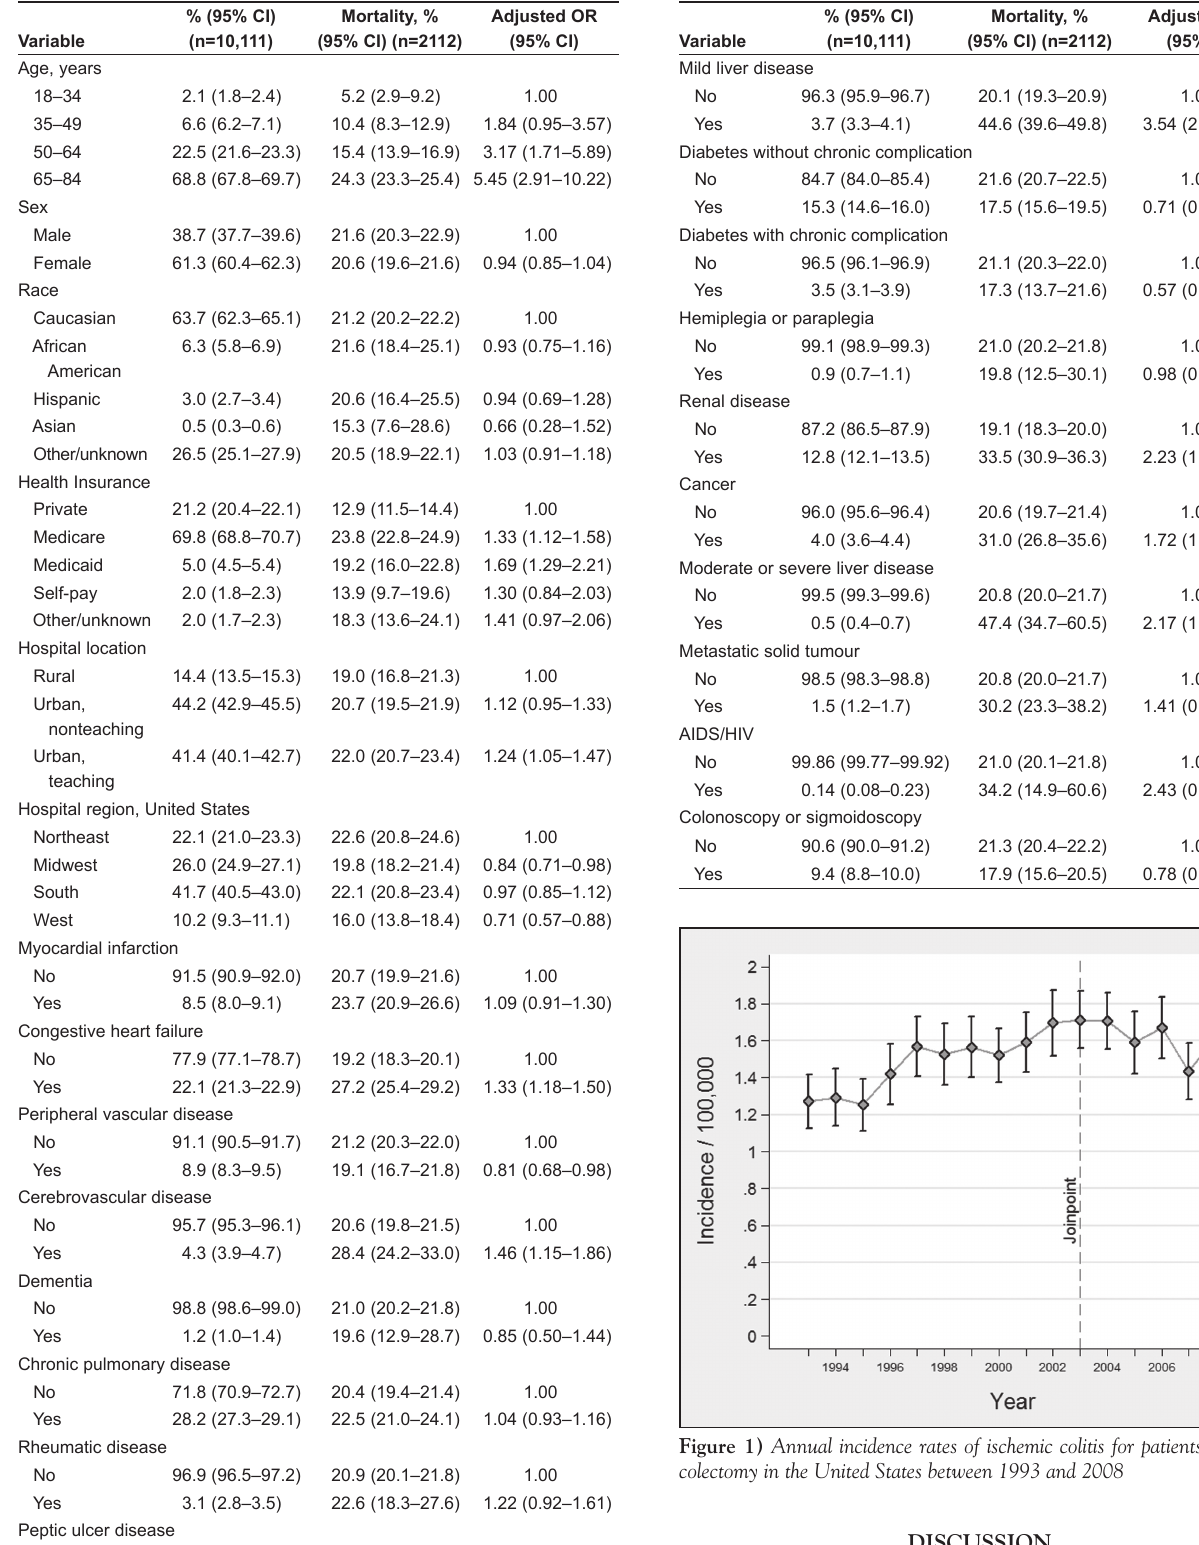
TAbLe 1 – CONTINUeD Predictors of in-hospital mortality in patients who underwent colectomy for ischemic colitis between 1993 and